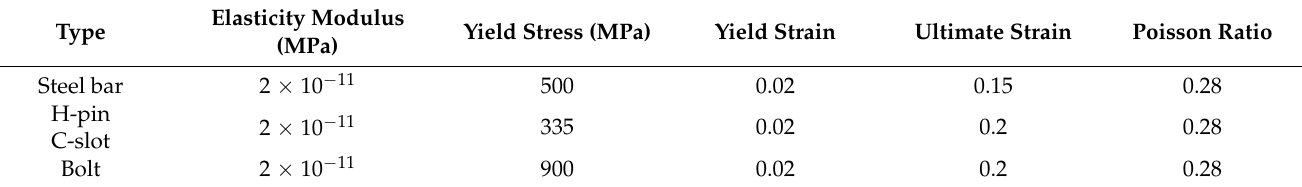
Table 2. Material properties of steel at room temperature.